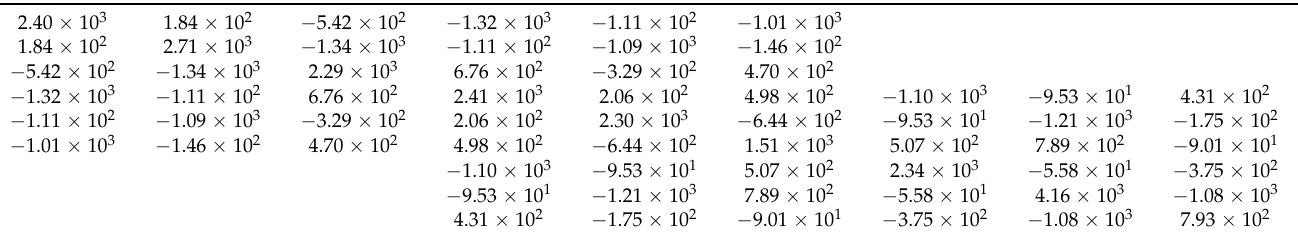
Table 2. Tangent stiffness matrix of the partial non-linear model in the undeformed